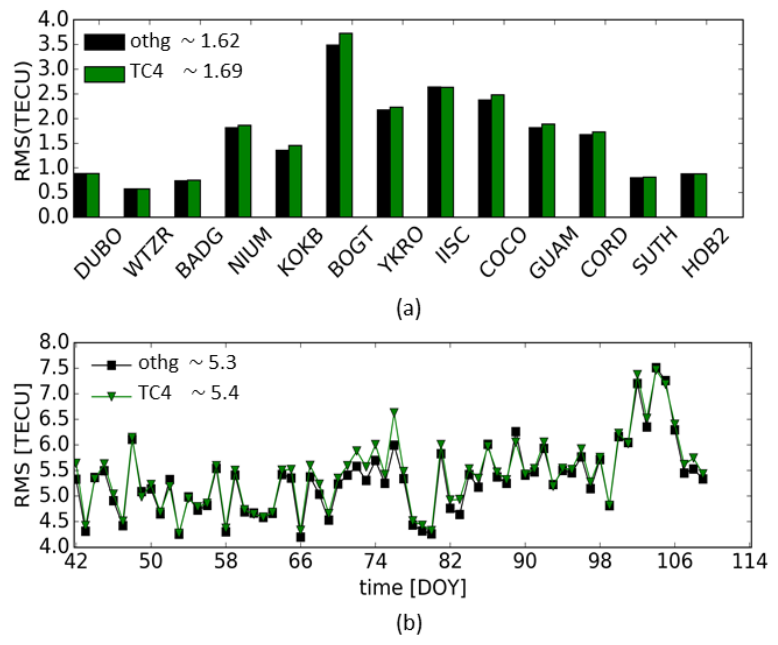
Figure 7. Comparison of “othg” and “TC4” solutions in terms of RMS deviations; ( a ) RMS values from the dSTEC analysis at the GNSS stations depicted in panel ( a ) of Figure 4; ( b ) daily RMS deviations with respect to the altimeter VTEC data from the Jason-2 mission. The results refer to the data set covering the days between DOY 42 and DOY 110 of year